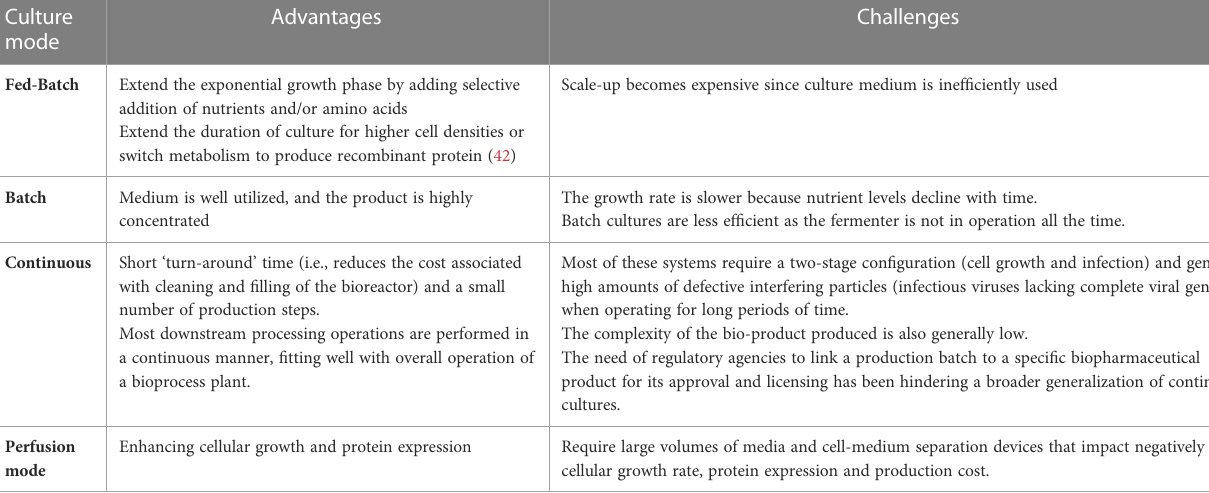
TABLE 3 Advantages/challenges associated with the various culture modes used for the production of VLPs.